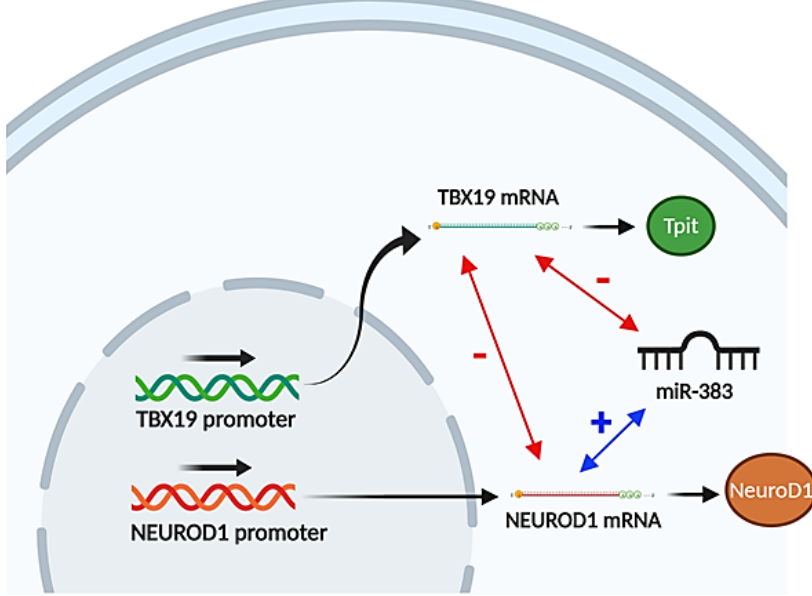
Figure 3. Correlations among TBX19 , NEUROD1 and miR-383. According to this scheme, miR-383 could negatively modulate the expression of the transcription factor of the corticotroph lineage, Tpit, through the direct inhibition of TBX19 mRNA and by the indirect stimulation of NEUROD1 mRNA.